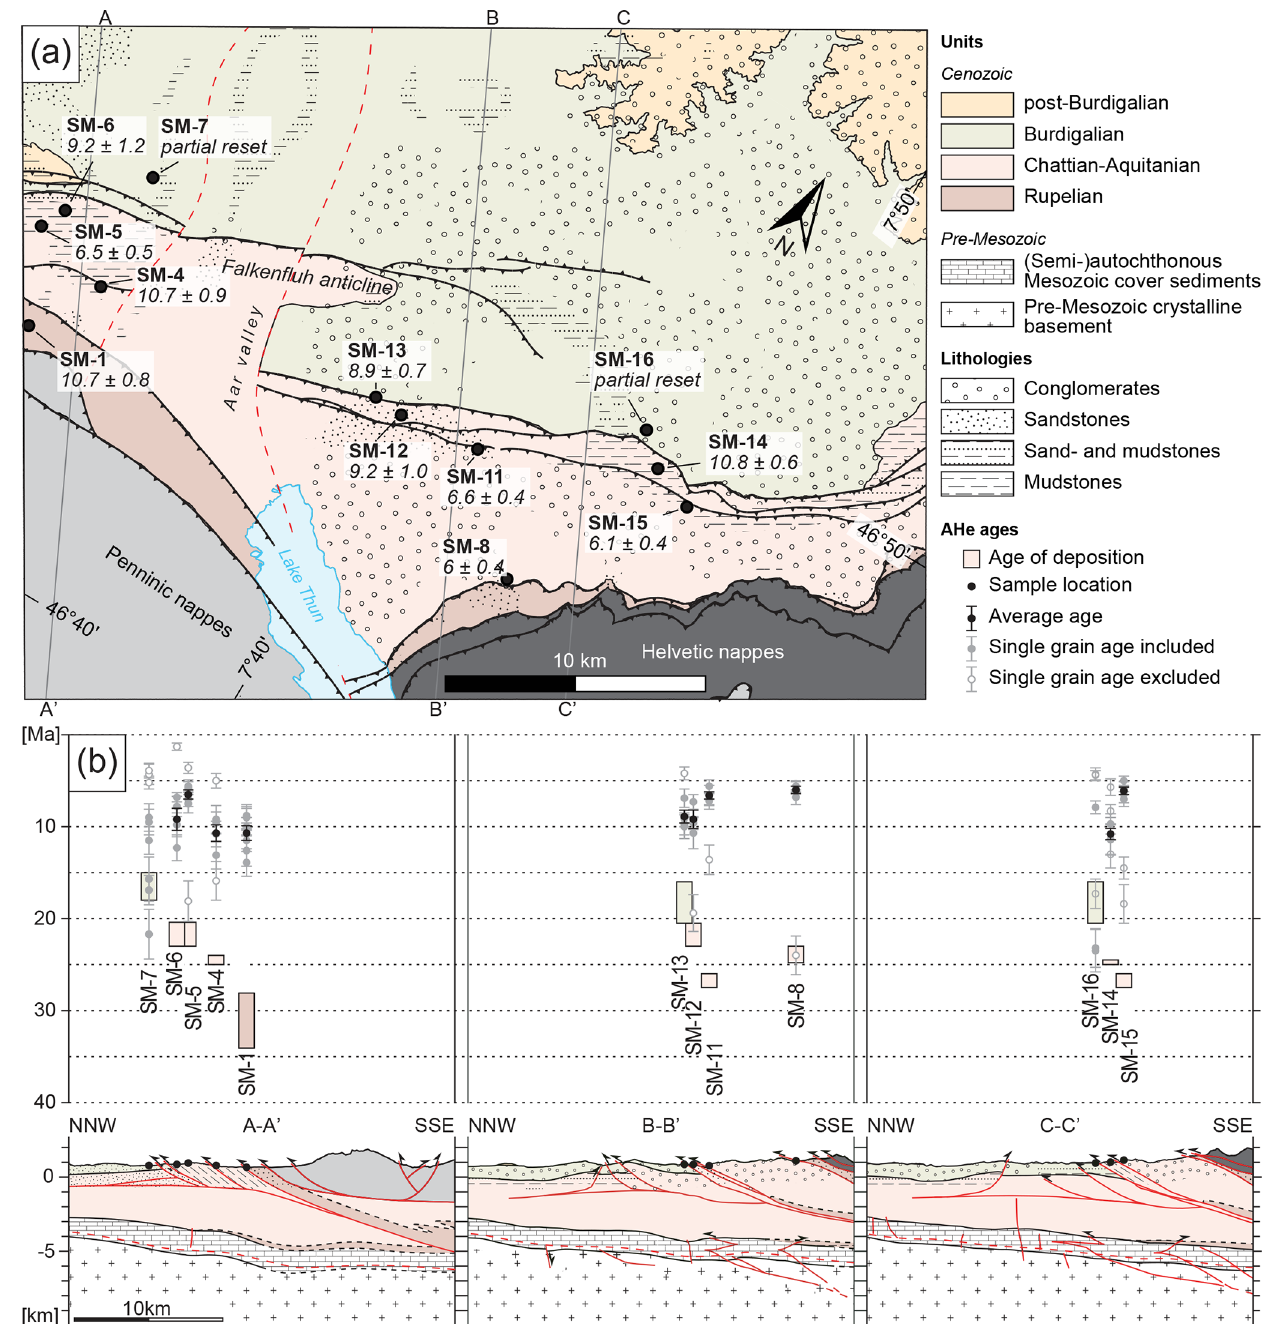
Figure 3. (a) Litho-tectonic map of the Lake Thun area showing sample locations and corresponding average apatite ( U − Th − Sm )/ He (AHe) ages. Traces of cross sections A–A’, B–B’, and C–C’ in Fig. 3b are given as black lines. The location of the sampling area is shown as a dashed rectangle in Fig. 1. Note the arrow indicating north. (b) Cross sections through the sampling area west (A–A’) and east of the Aar valley (B–B’ and C–C’), showing single-grain and average AHe ages. Tectonic information is based on Beck (1945), Haus (1937), Jordi (2012), Mock and Herwegh (2017), Rutsch (1947), and Schlunegger et al. (1993, 1997). Lithological information is compiled from Landesgeologie (2005) and Schlunegger et al.